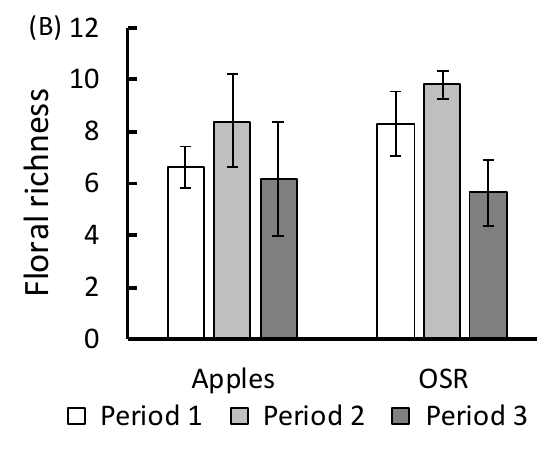
Results of REML repeated measures analysis ( P -values) examining the effects of crop type (apples/ OSR) and period (flowering period/ 1-month after flowering period / 3-month after flowering period) on abundance and diversity of flowering plants in the field boundary. Site was included in the REML model as a